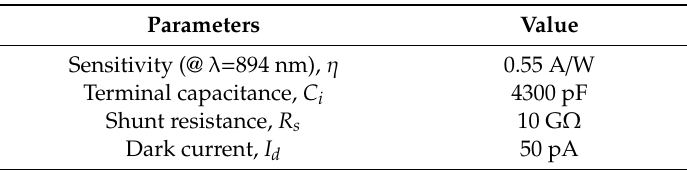
Table 1. Main parameters of S2387-66R.